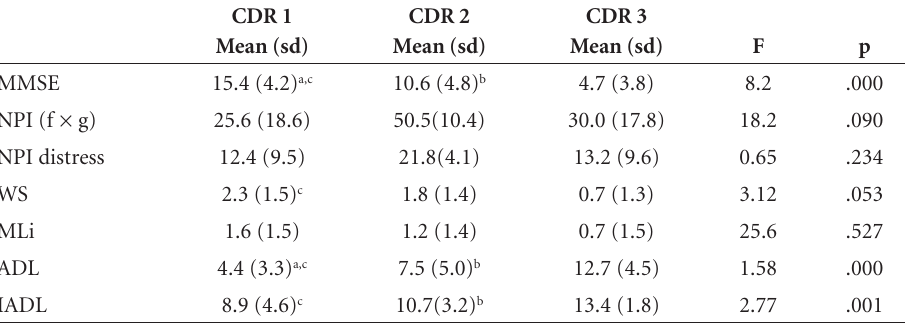
Table 3. Variables associated with dementia